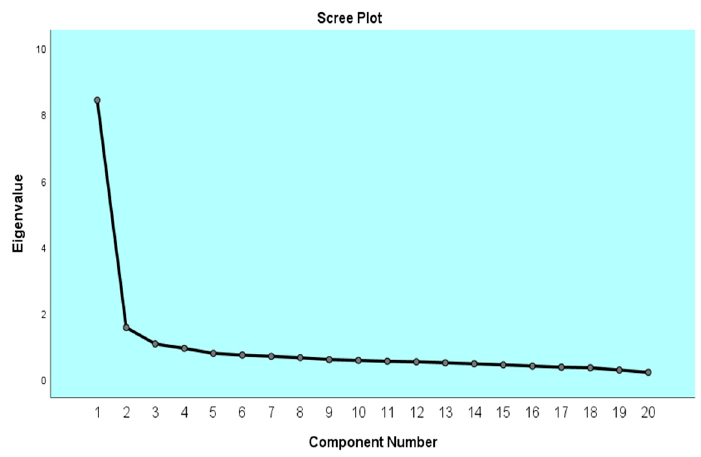
Figure 1. Scree plot to examine the number of EATS factors.